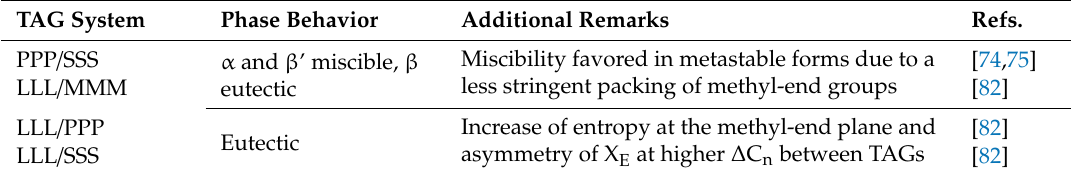
Table 1. Phase behavior in binary mixtures of monoacid tri-saturated TAGs.